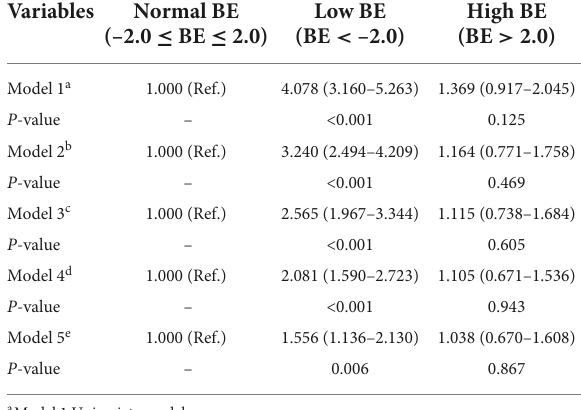
TABLE 2 Cox proportional hazard models for 28-day all-cause death.